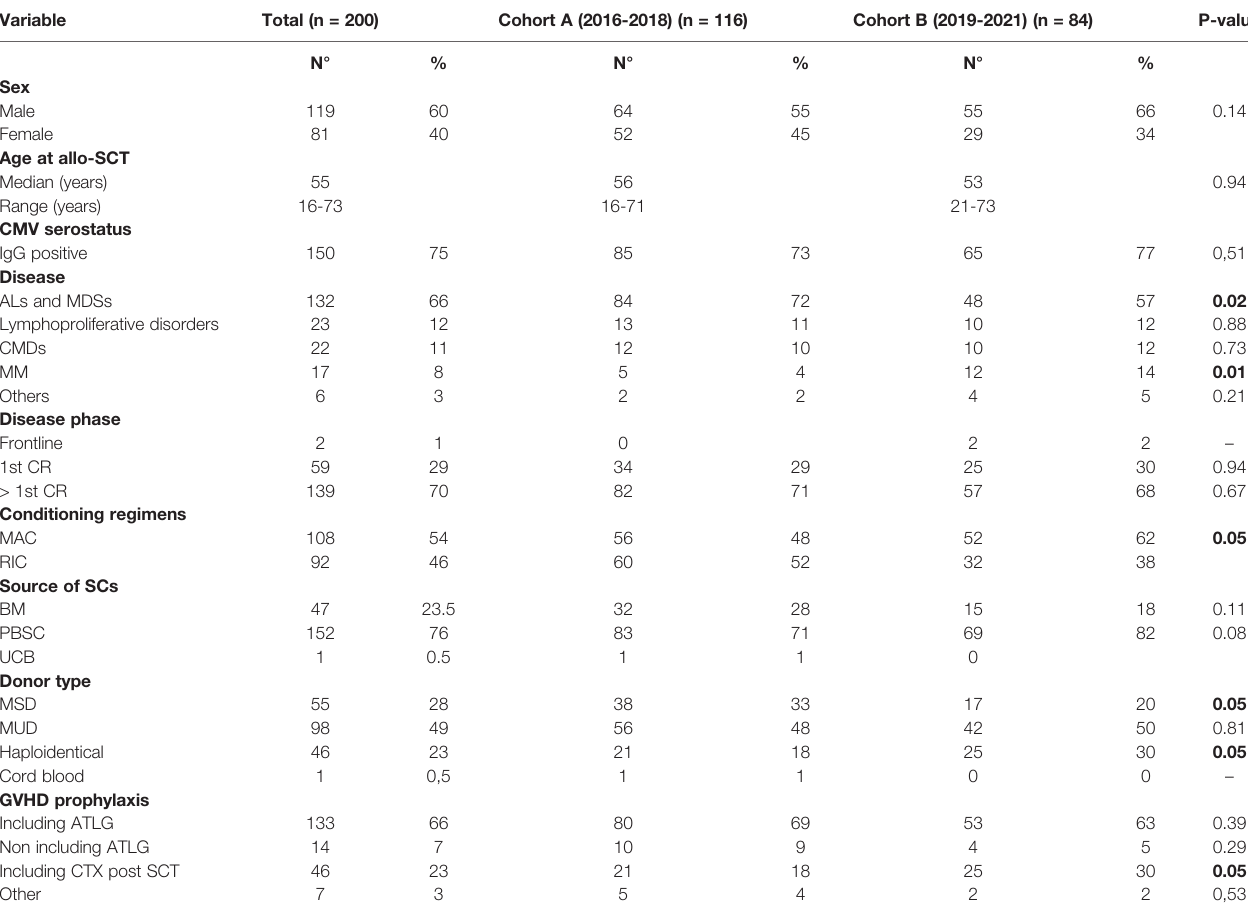
TABLE 2 | Clinical and transplant characteristics of the 200 allotransplanted patients included in this analysis.